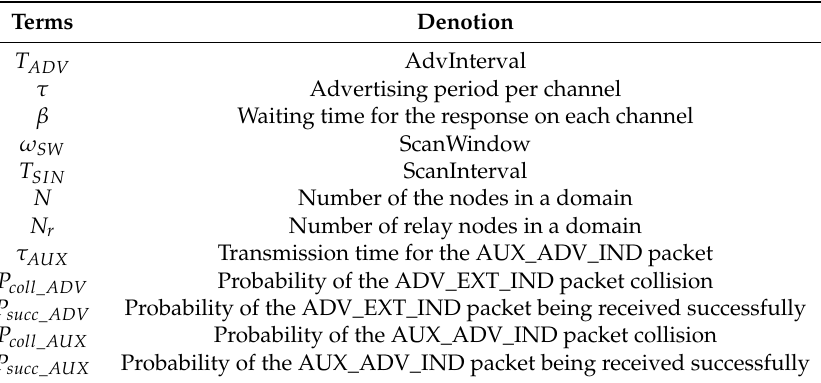
Table 3. The terms utilized in the